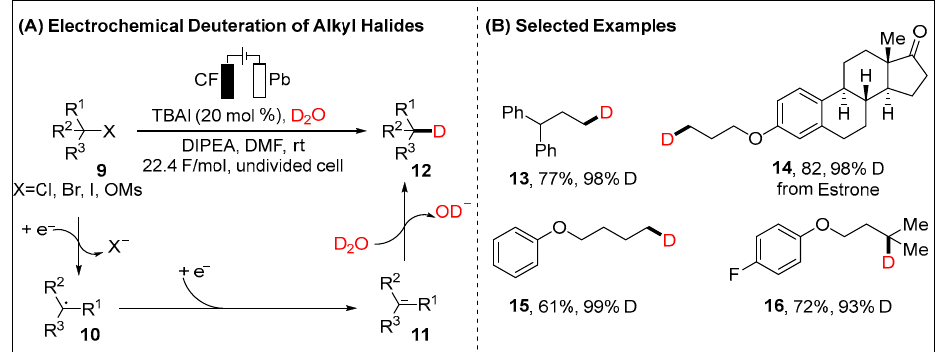
Figure 4. Electrochemical deuteration of unactivated alkyl halides by Qiu group.